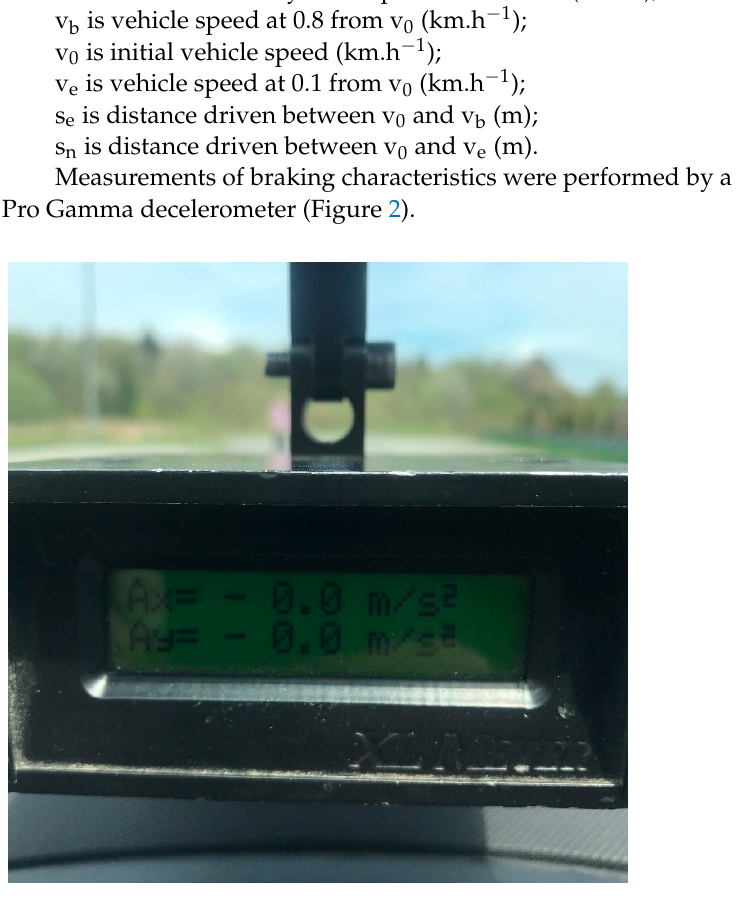
Figure 2. D ecelerometer used for measuring. Figure 2. Decelerometer used for measuring.